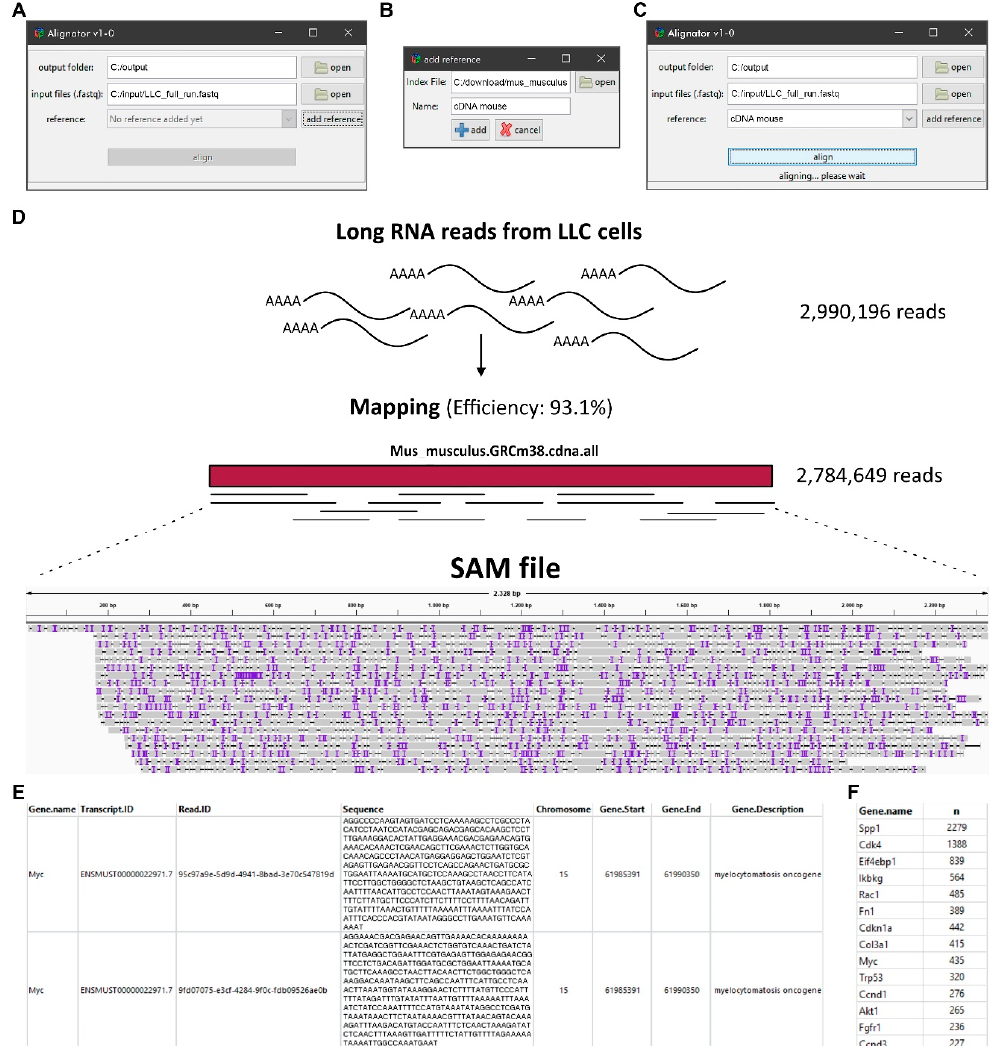
Figure 3. The interface of the Alignator v1 and output files. ( A ) Main window with options to set-up the output folder and input files as well as an option for creating the index reference via the add reference button. ( B ) The add reference window with the option to choose the index file (e.g., a local copy of